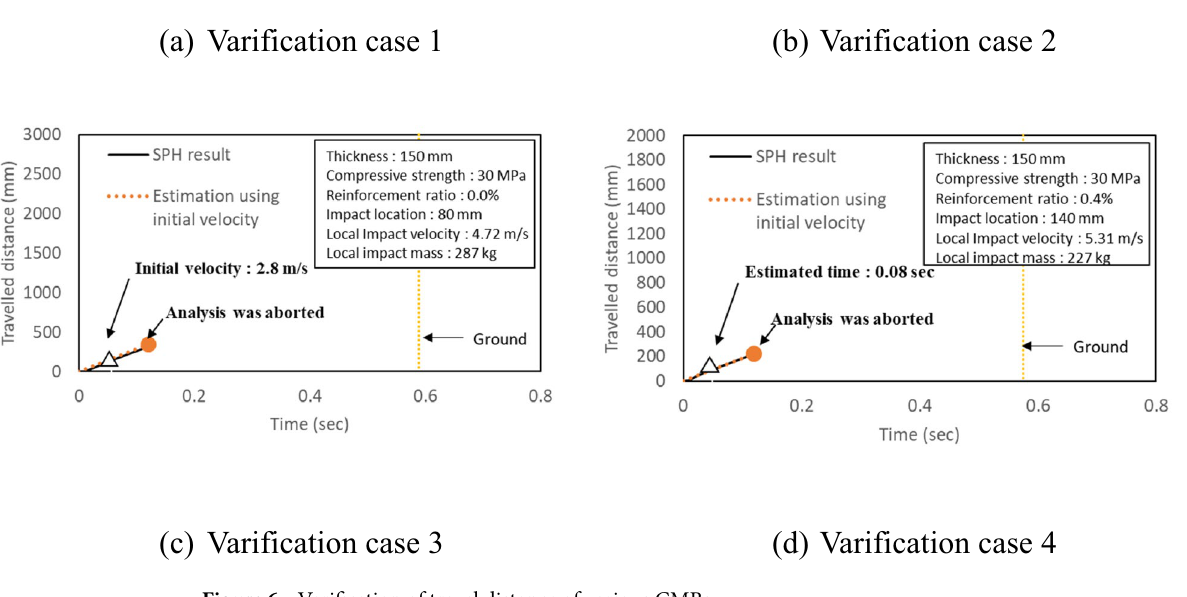
Figure 6. Verification of travel distance of various